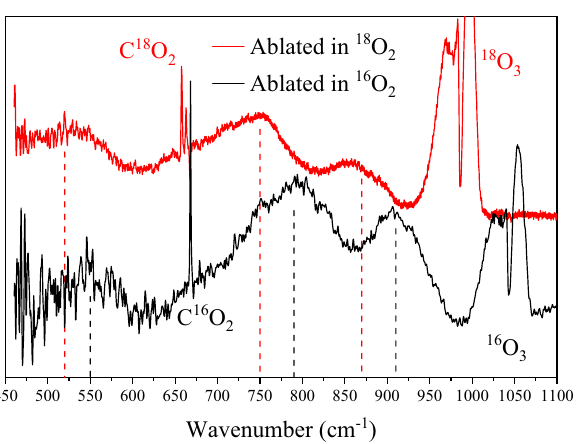
Figure 3. In-situ FTIR spectra of collected particulates after ablation of uranium in 100% O 2 (black) and 18 O 2 (red). The three am-UO x (3 ≤ x ≤ 4) features, indicated with dashed lines, shift to lower frequencies upon 18 O-substitution, as expected with oxygen-containing molecules. Furthermore, spectral features of ozone and carbon dioxide also shift confirming their formation during ablation. Spectra are offset for